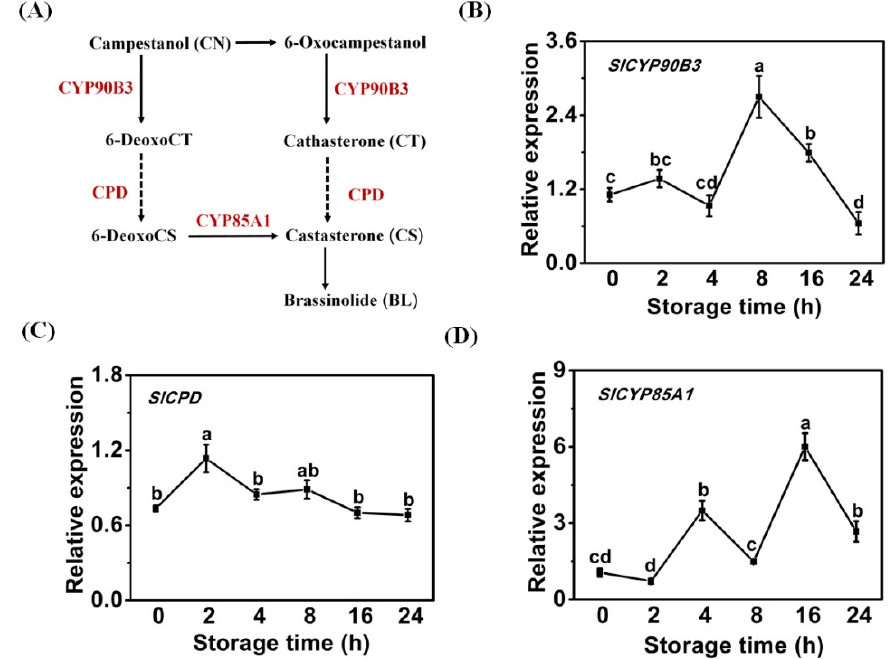
Figure 1. BR biosynthetic genes of tomato fruits were induced in response to cold storage. ( A ) BR biosynthetic pathway in tomato. ( B ) SlCYP90B3 expression. ( C ) SlCPD expression. ( D ) SlCYP85A1 expression. Each data point is means ± SE ( n = 3).